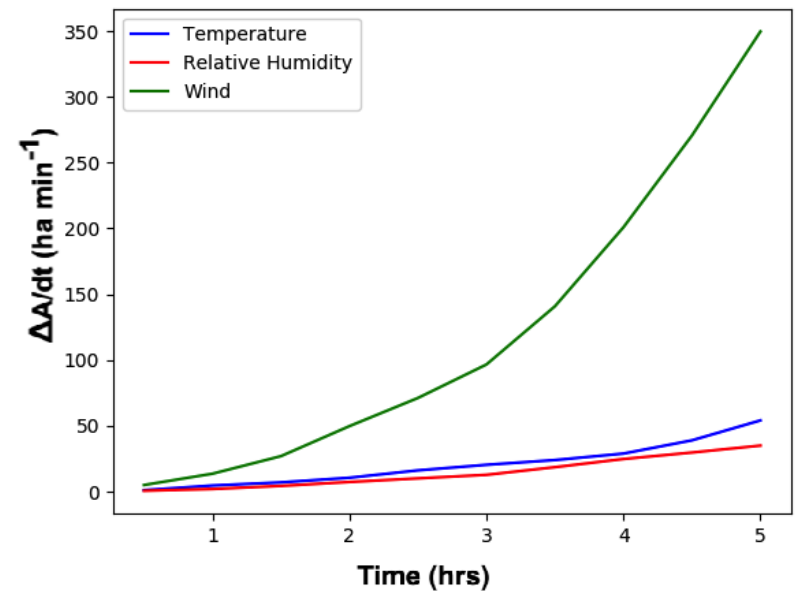
Figure 5. Rate of increase of fire area with time for Southern Ranges bio-region (The rate of increase in the fire area is in hectares per minute (ha min − 1 ). The contributions in the rate of change of fire area made by temperature (blue line) and relative humidity (red) are steady over time while the same made by the wind speed (green) increases exponentially over